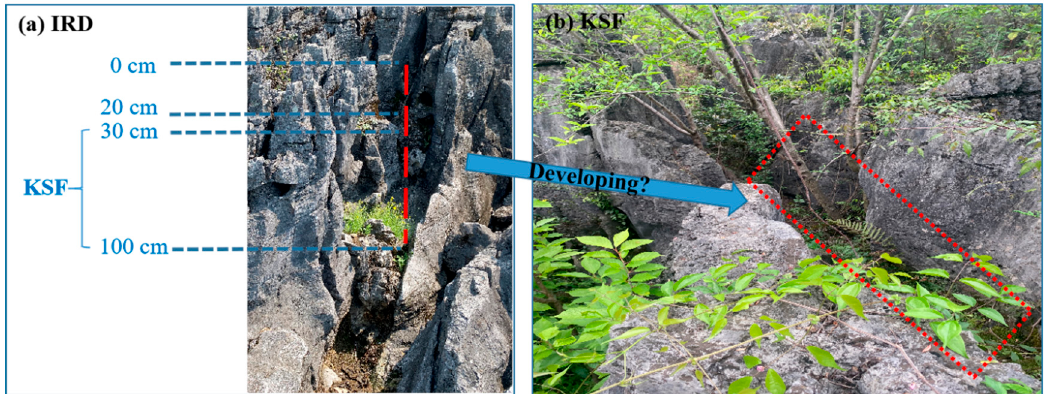
Figure 8. Comparison between intense rocky desertification and karst shallow fissure, ( a ): intense rocky desertification (IRD), ( b ): karst shallow fissure (KSF).